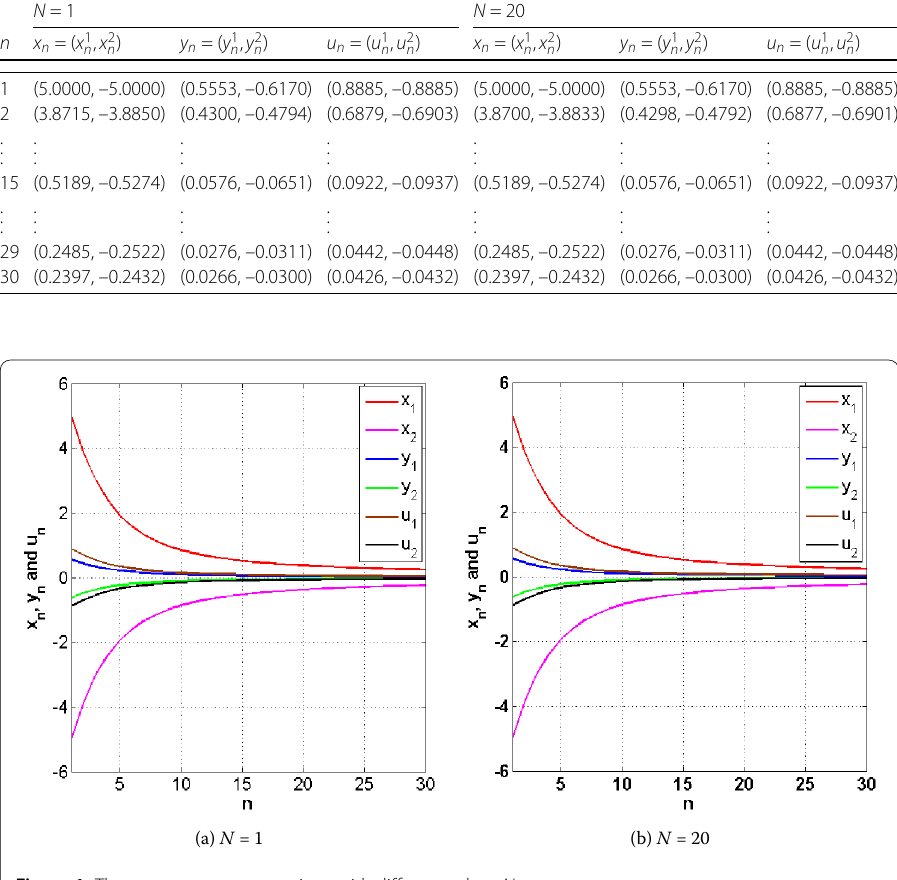
Figure 1 The convergence comparison with different values